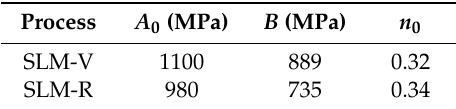
Table 2. The material constants in the J–C model for the SLMed Ti–6Al–4V alloy. Note that “SLM ‐ R” represents the SLM curve of the reference. represents the SLM curve of the reference.